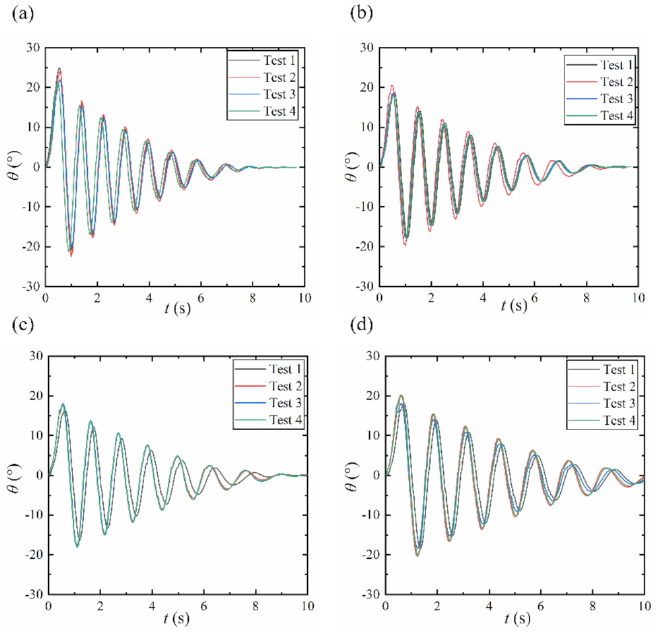
Figure 9. Free decay curves: ( a ) L / D = 4.0; ( b ) L / D = 6.0; ( c ) L / D = 7.0; ( d ) L / D = 9.0. Table 4. Free decay test results of f n,air at various spacing ratios.